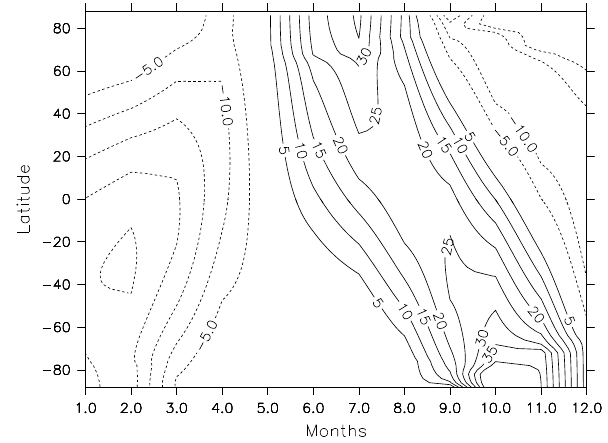
Fig. 4. Insolation difference Mid-Holocene (MH) minus Pre- Industrial (PI) in Wm − 2 , calculated using the equations of Berger (1978).